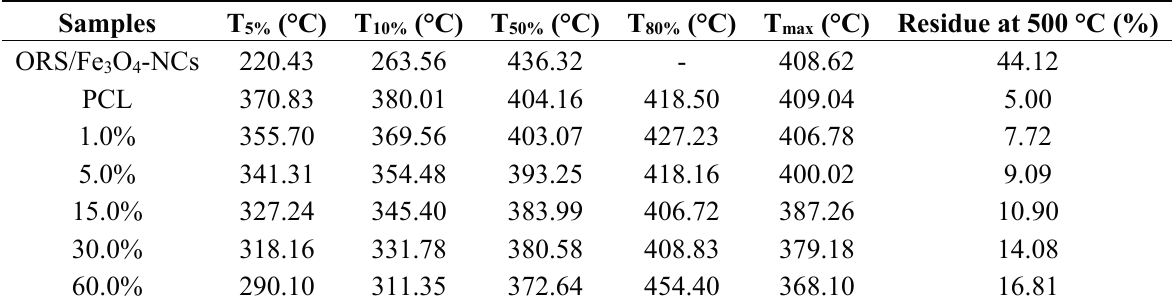
Table 1. Degradation temperature at 5.0%, 10.0%, 50.0% and 80.0% fiber degradation, obtained by the TGA and DTG.